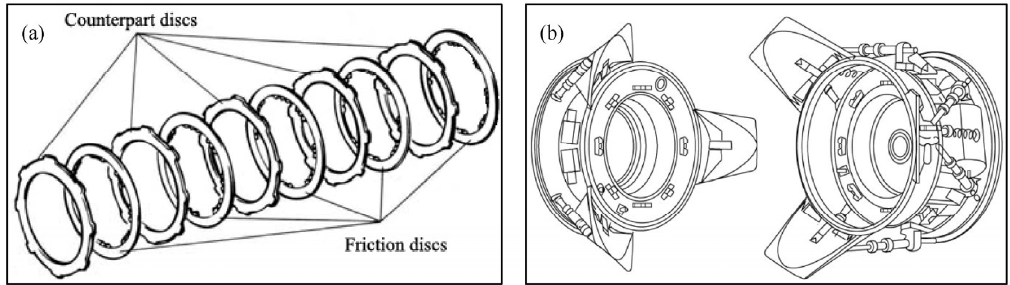
Fig. 10 Schematic view of (a) the friction pairs for (b) the docking